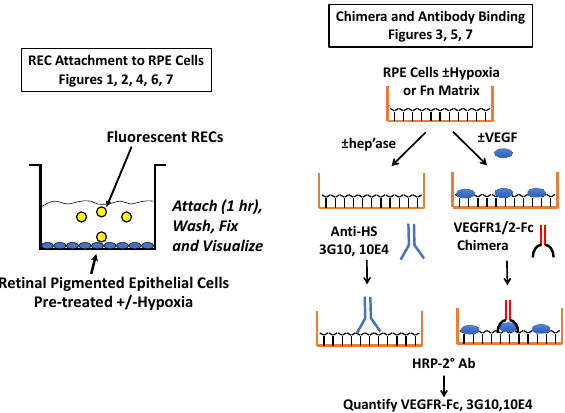
Figure 9. Schematic of key methods. On the left is the general cell attachment protocol. Fluorescent RECs were allowed to attach to RPEs that had been preconditioned ± hypoxia. In some studies, soluble antagonists were added with the RECs and in others the cells were treated prior to REC attachment (i.e., with VEGF or heparinase III). On the right is the general approach used to evaluate VEGF-receptor binding to RPEs and Fn, as well as the method used to analyze HS levels on RPEs.